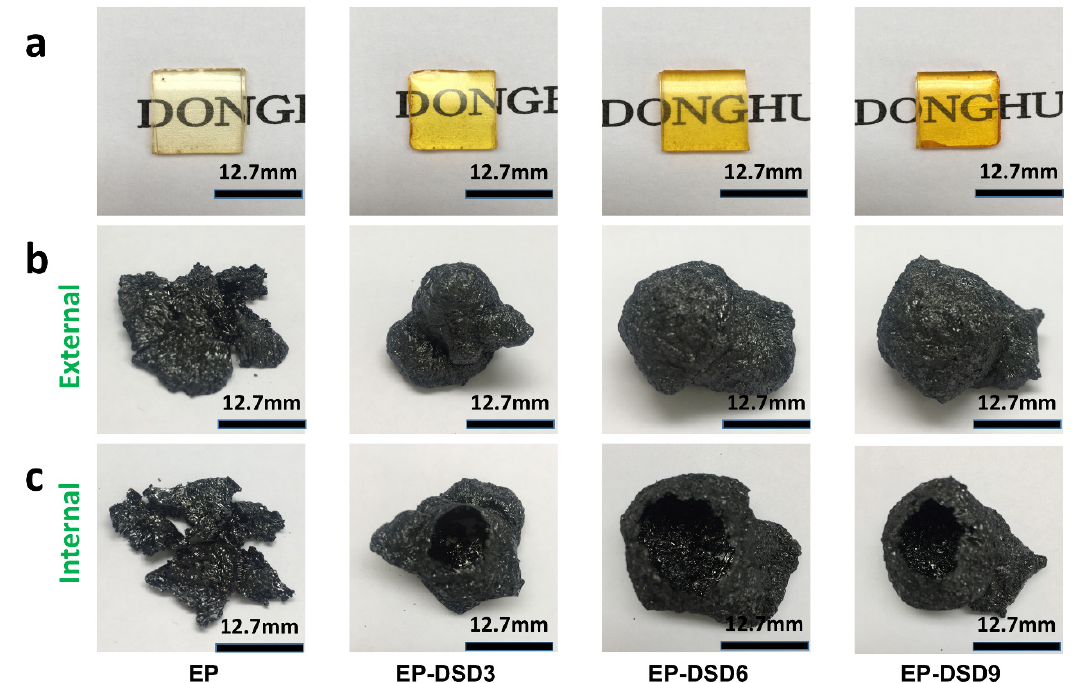
Figure 5. Digital photos of epoxy thermosets before ( a ) and after ( b , c ) thermal degradation in nitrogen.